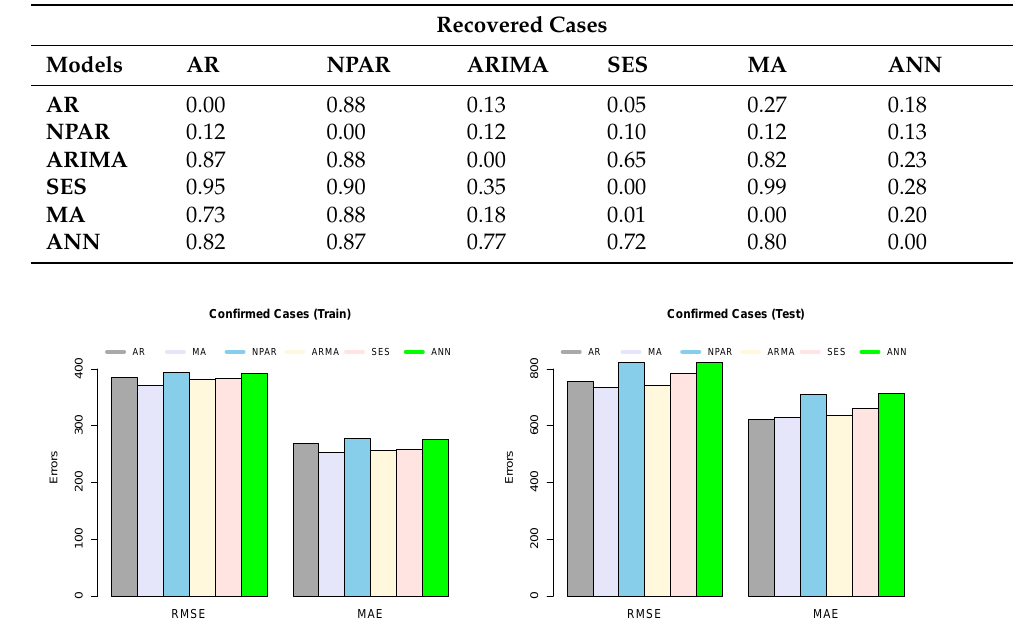
Table 7. Results ( p -value) of the DM test for all the considered models using the recovered cases.